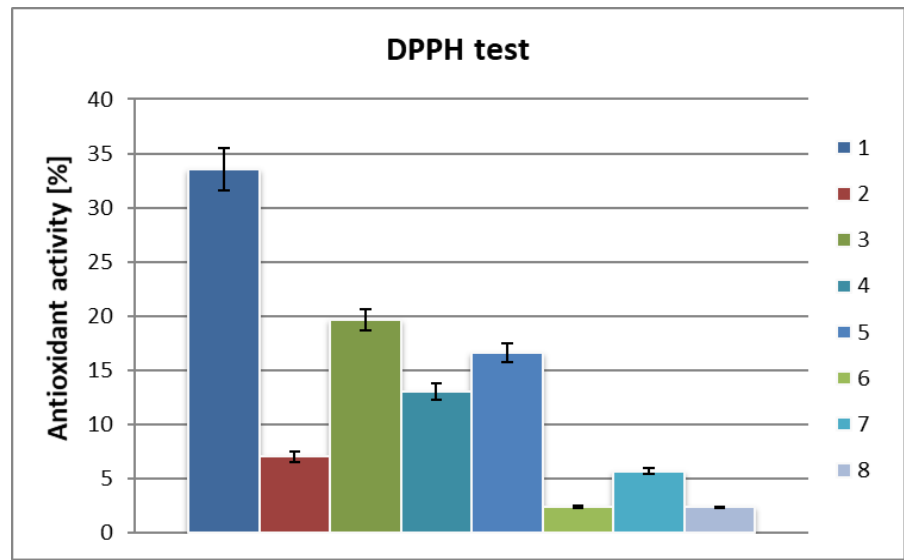
Figure 2. Total antioxidant activity of hydrophilic fractions from algae biomass separated by ultrafiltration: ( 1 ) ascorbic acid 1 nM (0.17 mg/mL); ( 2 ) water extract (before separation) c = 0.5 mg/mL; ( 3 ) residue on the 50 kDa filter, c = 0.5 mg/mL; ( 4 ) residue on the 10 kDa filter, c = 0.5 mg/mL; ( 5 ) residue on the 5 kDa filter, c = 0.5 mg/mL; ( 6 ) filtrate after separation on the 50 kDa filter, c = 0.5 mg/mL; ( 7 ) filtrate after separation on the 10 kDa filter, c = 0.5 mg/mL; ( 8 ) filtrate after separation on the 5 kDa filter, c = 0.5 mg/mL.